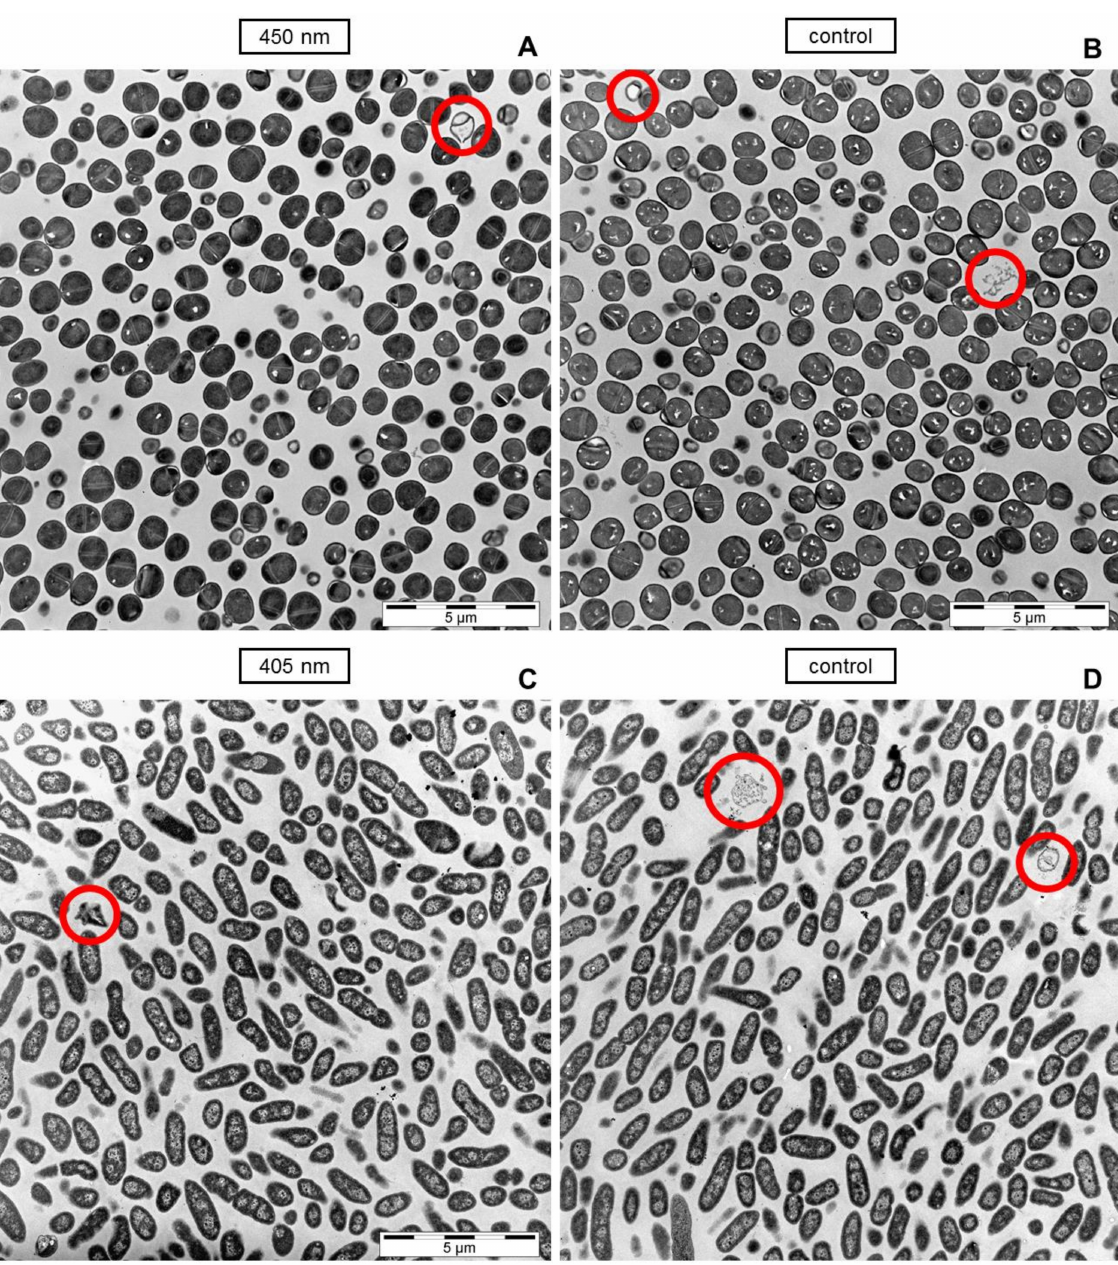
Figure 5. Transmission electron images of S. carnosus ( A , B ) and P. fluorescens ( C , D ) demonstrating on overview of bacterial appearance after 450 nm irradiation ( A ) and 405 nm irradiation ( C ) compared to the controls respectively ( B , D ). Circles are indicating potentially conspicuous individual cells. Scale bars show the magnification, representing 5 µ m ( A – D